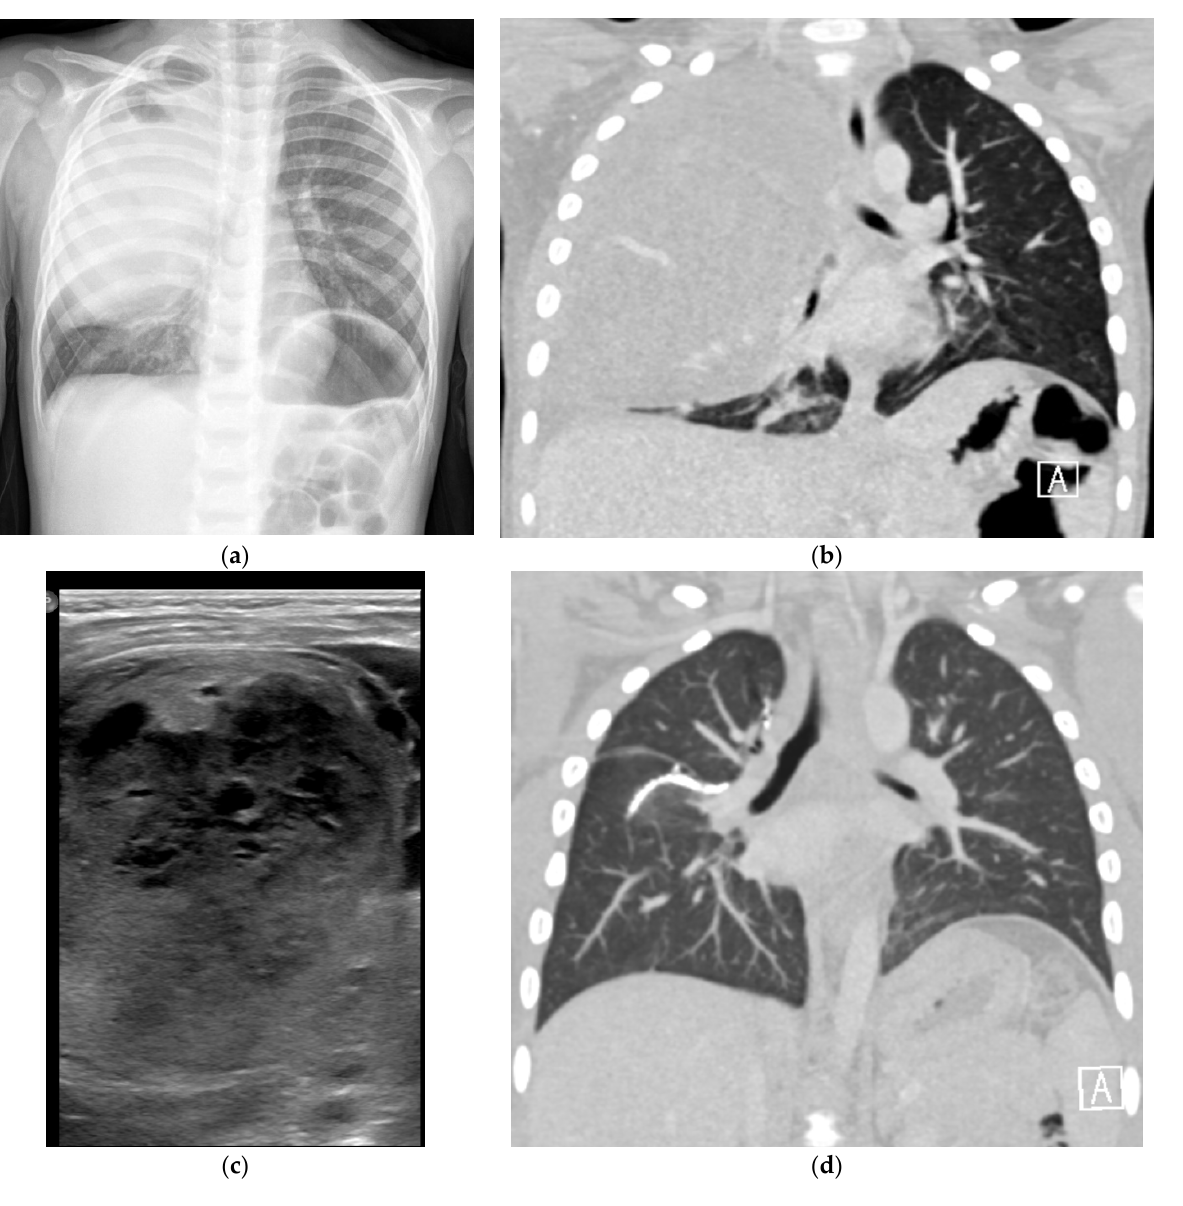
Figure 4. Six-year-old boy with progressive shortness of breath, fatigue and weight loss. ( a ) Chest X-ray: Opacification of the upper two thirds of the right upper hemithorax by a pleural-based lesion. There is a slight shift of the trachea to the left, and a caudal shift of the right diaphragm. ( b ) Coronal image of CTA showing large aberrant vessels within the lesion. ( c ) Sonographic gray-scale high- resolution image of the lesion (linear array transducer) shows the cystic/solid nature of the lesion. ( d ) Coronal image of CTA at the end of treatment, showing no evidence of recurrent disease.